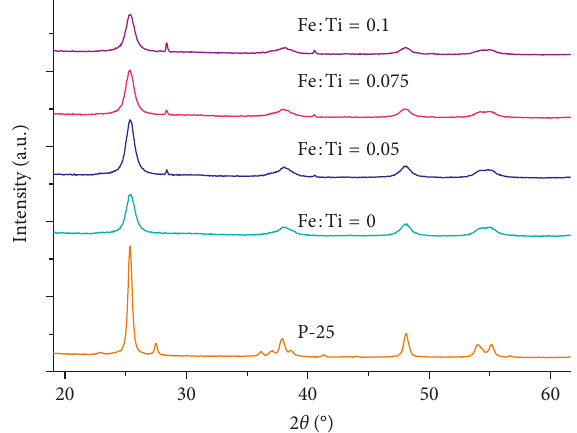
3+ : Ti Figure 4: Raman spectra of TiO Ti molar